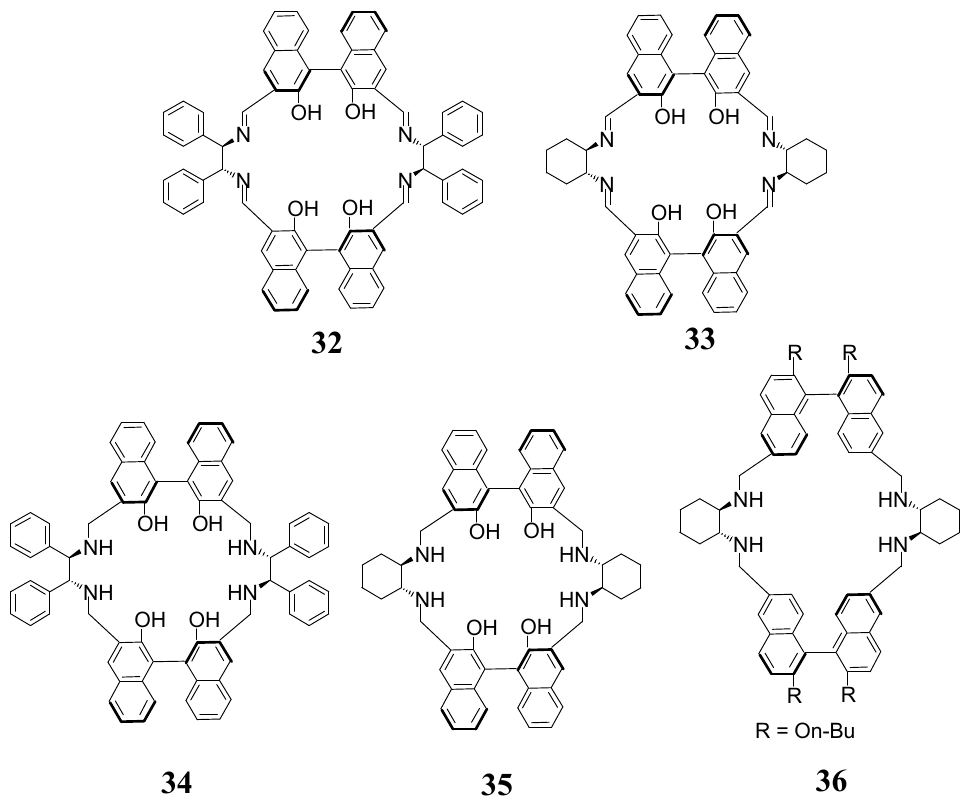
Figure 13. [2 + 2] macrocycles used as fluorescent detectors of guests.